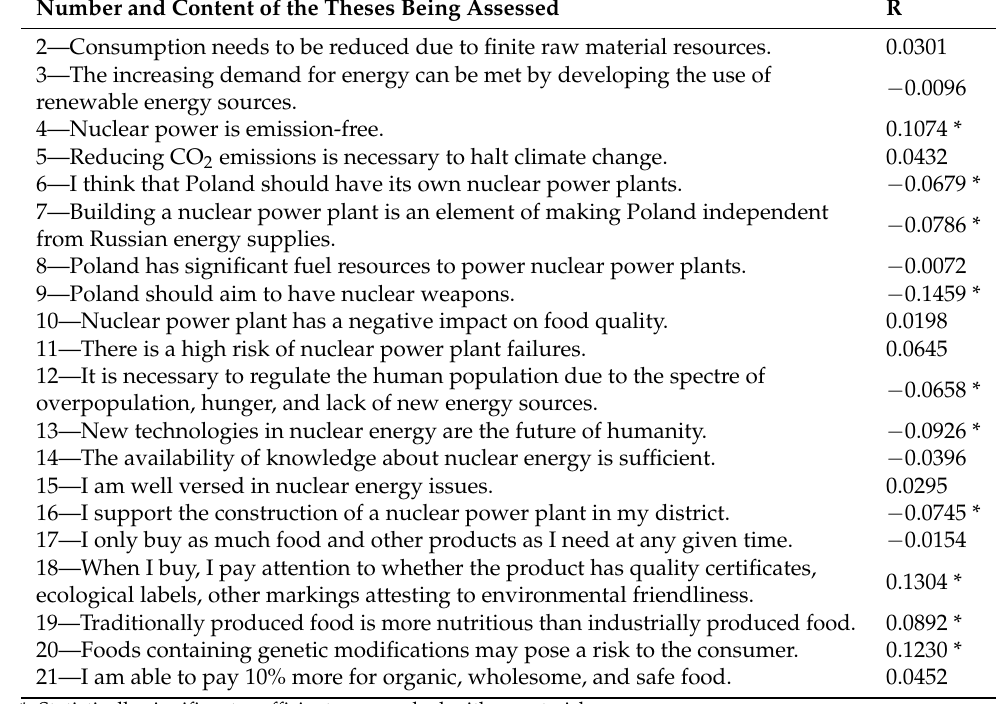
Table 8. The values of Pearson’s correlation coefficients between the assessments of individual theses and the age of respondents * (own research).